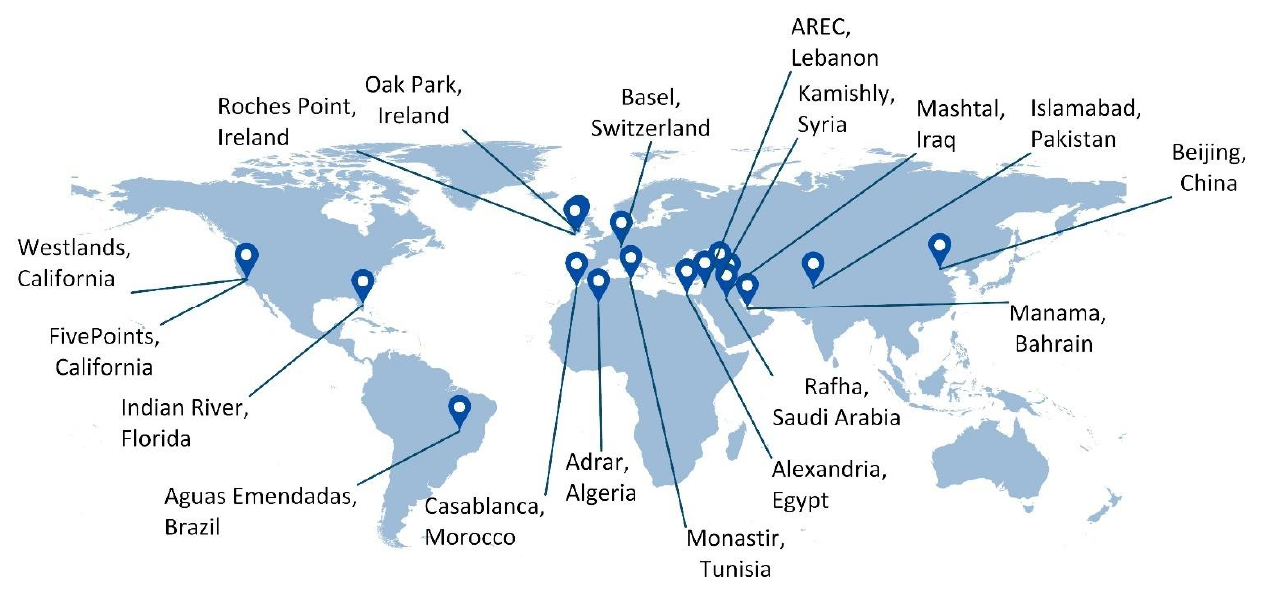
Figure 3. Location of the 18 weather stations used in the study.